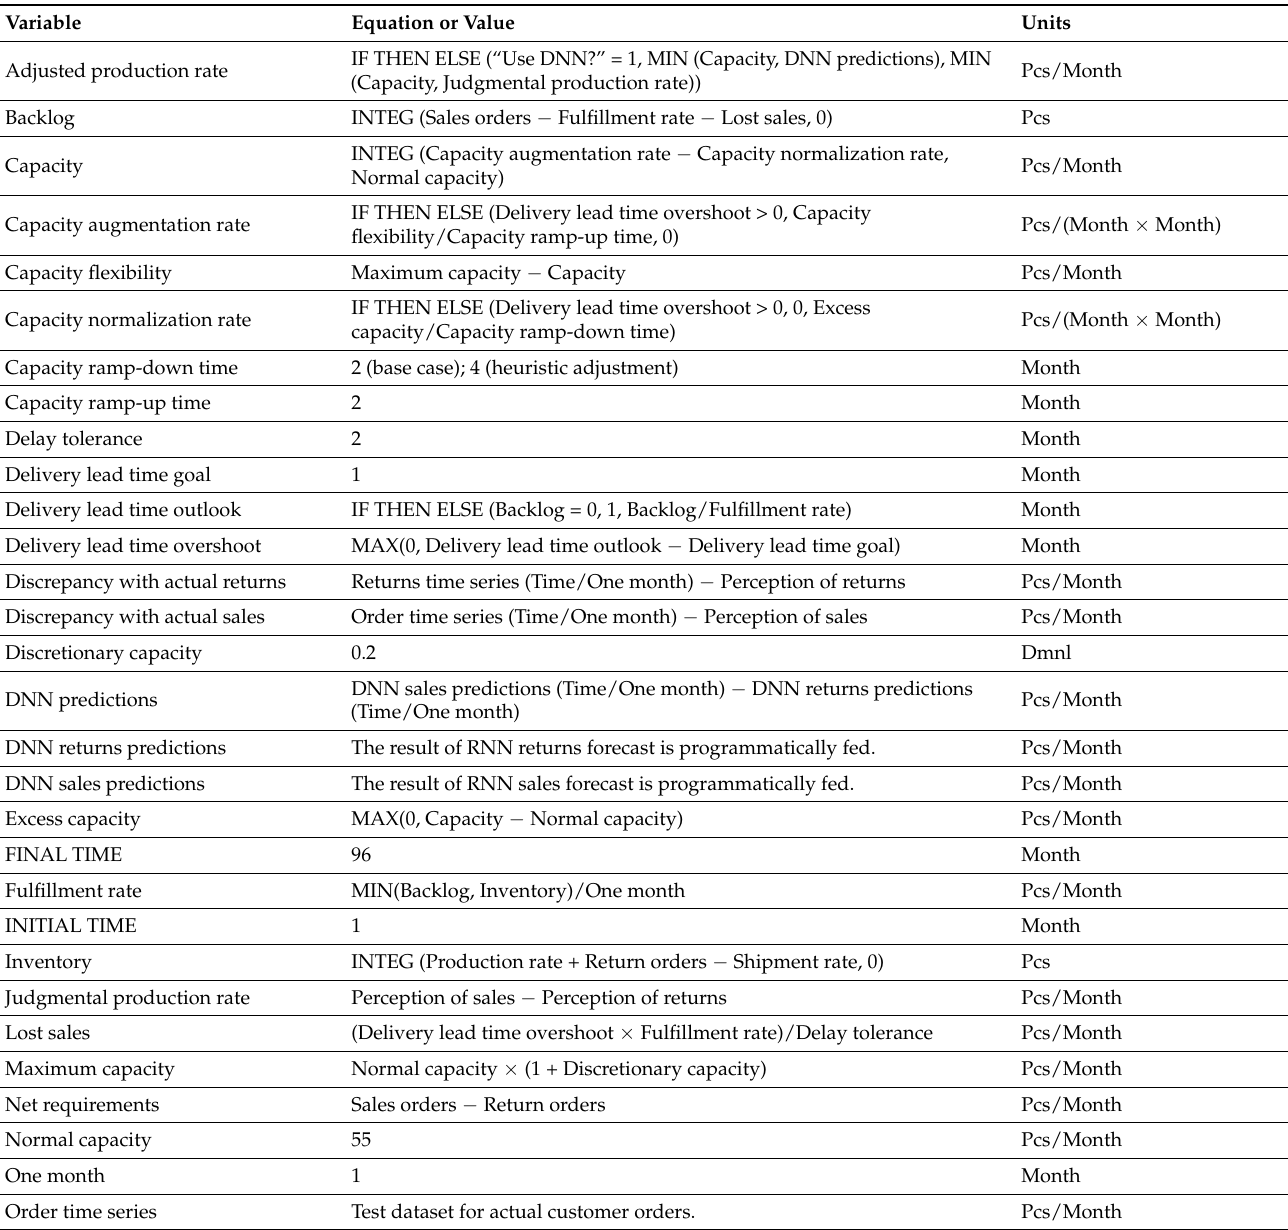
Table A1. System dynamics